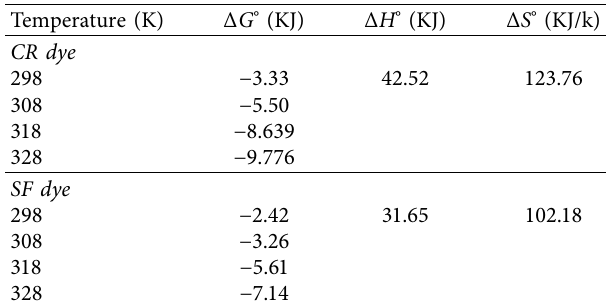
Figure 9: Elovich adsorption kinetics of (a) CR and (b) SF onto APC. Table 3: Thermodynamics parameters of CR and SF Dyes on APC.